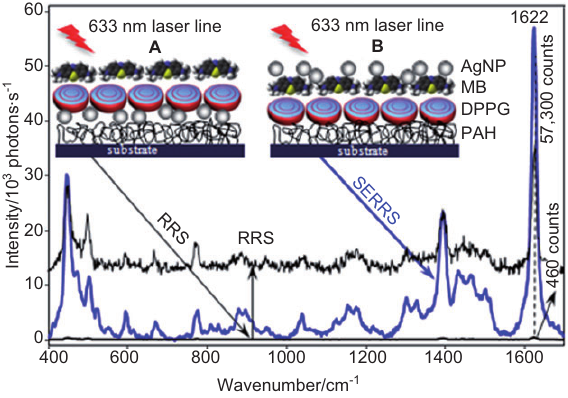
Figure 1 Raman and SERS spectra obtained for the molecular archi- tectures of LbL films shown in (A) and (B). Insets: illustration for SERS amplification – laser incident on the target molecule (MB) in the absence (A: Raman signal) and presence of AgNPs (B: SERS) in direct contact with the molecules of MB. PAH, poly(allylamine hydro- chloride) – polyelectrolyte used as a supporting layer. Reproduced/ adapted with permission from: Aoki et al. (2010) . Copyright 2009, John Wiley and